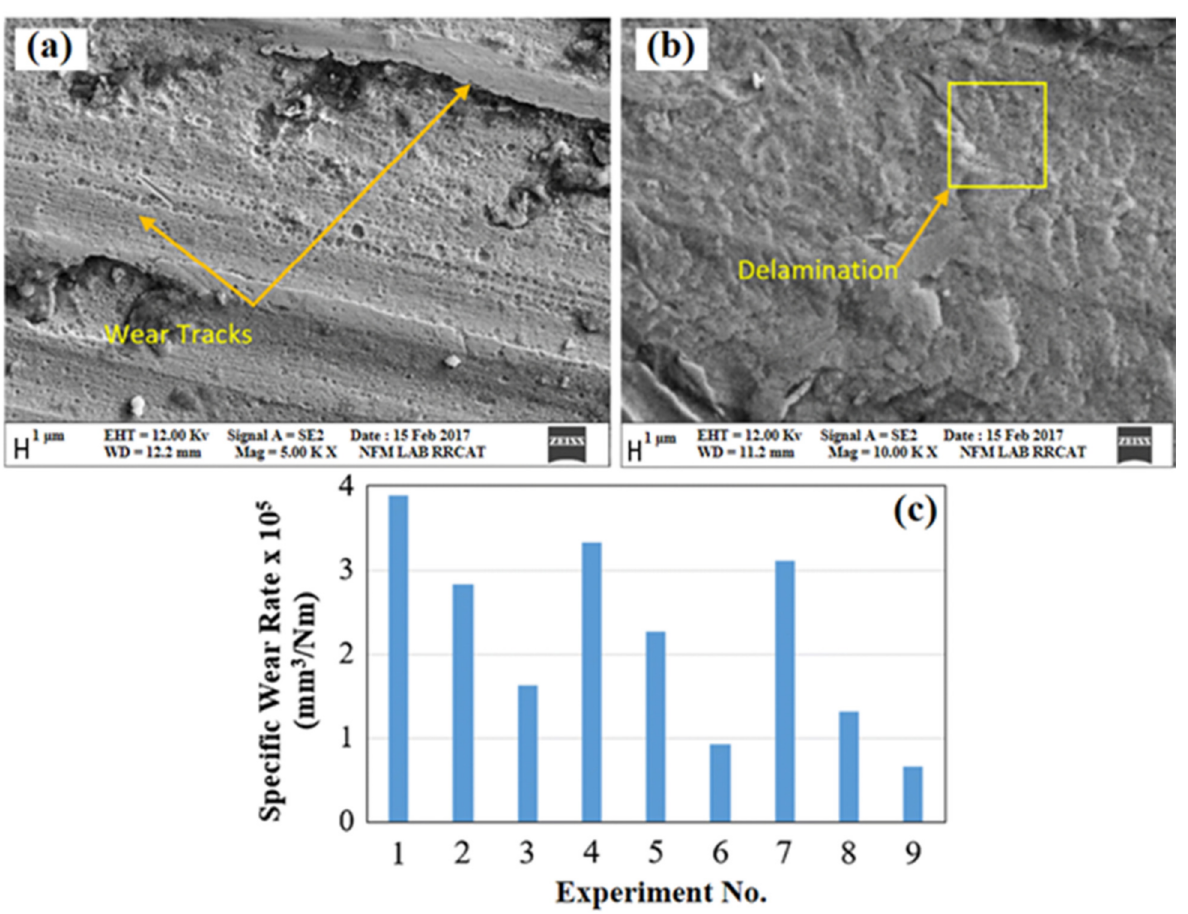
Figure 10. Schematic of a wear surface of a treated sample under different magnification. ( a ) lower magnification; ( b ) higher magnification. ( c ) comparison with untreated sample. (Reprinted with permission from ref. [107]. Copyright 2019